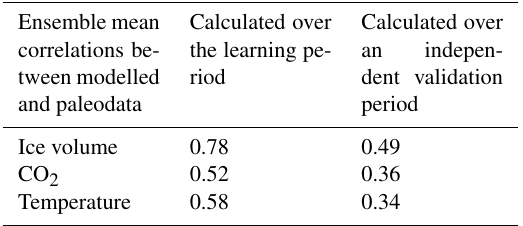
Table A1. Estimation of model predictive skill. Only solutions lead- ing to a correlation between modelled and paleo-estimation of ice volume higher than 0.7, calculated over the training period, are con- sidered. See text for more details on the training and validation pe- riods